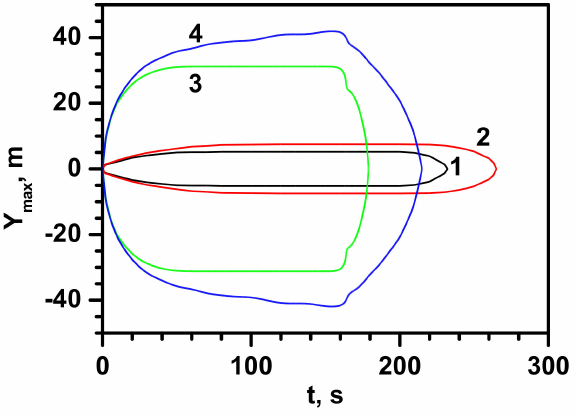
Figure 9. Maximum cloud width Y max determined for 50% LEL and 100% LEL calculated for the Gaussian gas (PG) and dense gas (DG) models as a function of time. Designations: (1) PG 100% LEL; (2) PG 50% LEL; (3) DG 100% LEL; (4) 50% LEL. Atmospheric conditions of the measurement series 3: T = 20.3 ◦ C, v = 0.67 m/s, RH = 44%, p = 1002.7 hPa. Release parameters: Q = 1.7 kg/s, p out = 5.9 atm, t = 163 s, h = 0.75